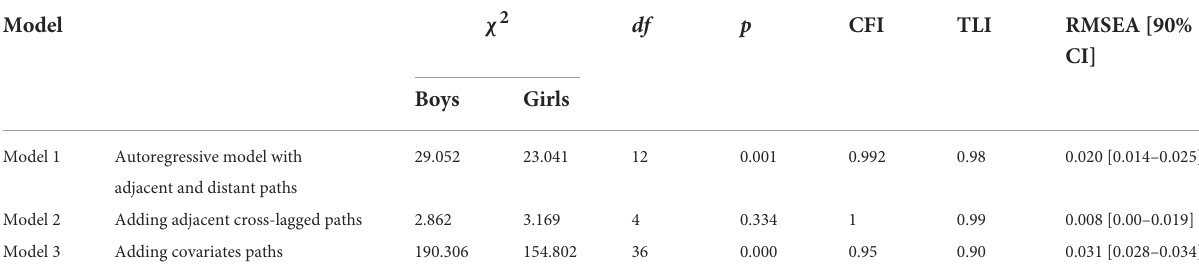
TABLE 2 Models of the reciprocal relations between PA and SDQ-Total. Model